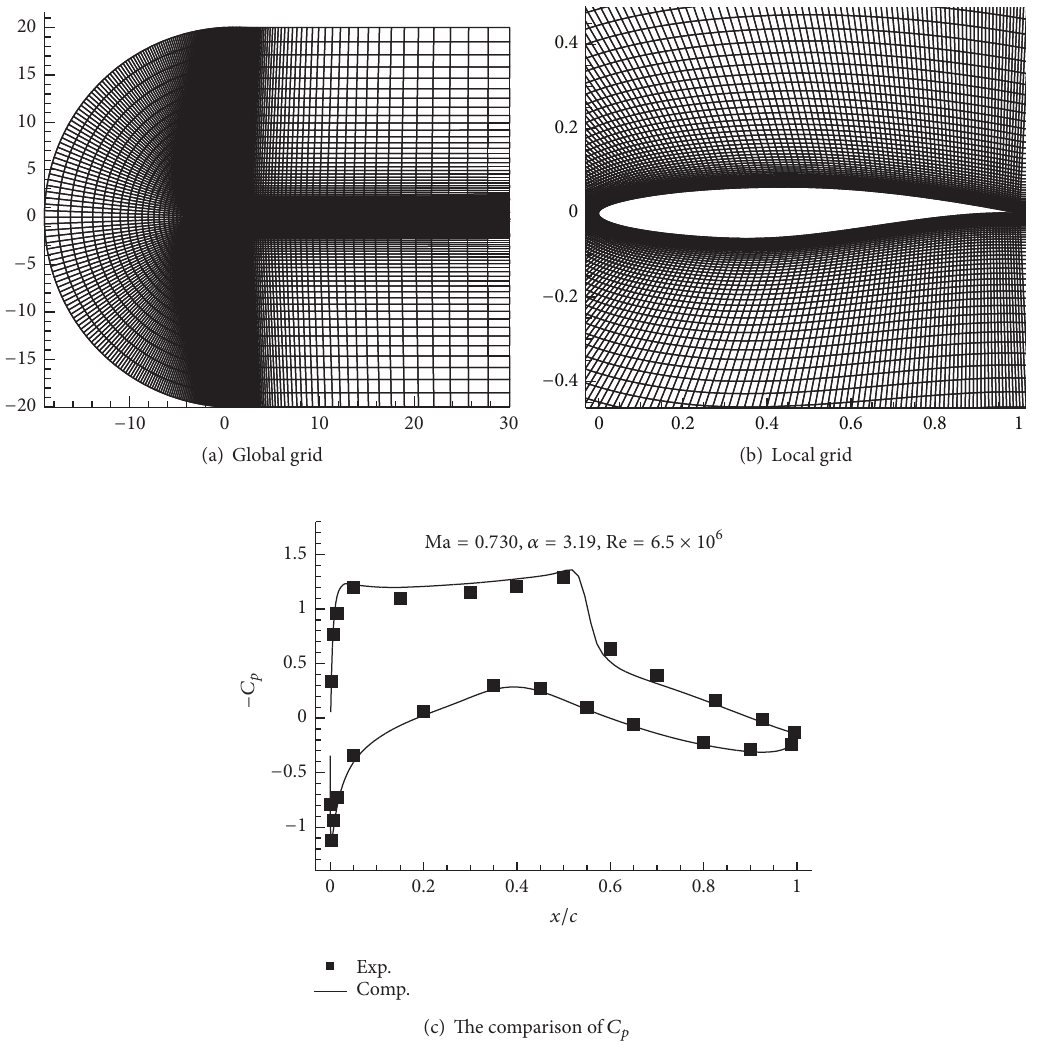
Figure 3: Computing grids of RAE2822 and the reliability verification of the CFD program.